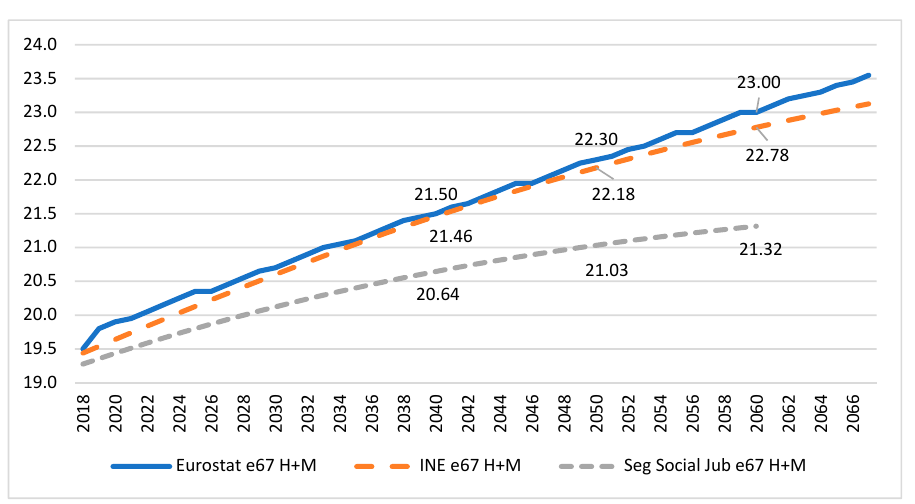
Figure 2. Life expectancy at 67 years. INE, Eurostat, and Social Security retiree tables. Source: Prepared by the authors.